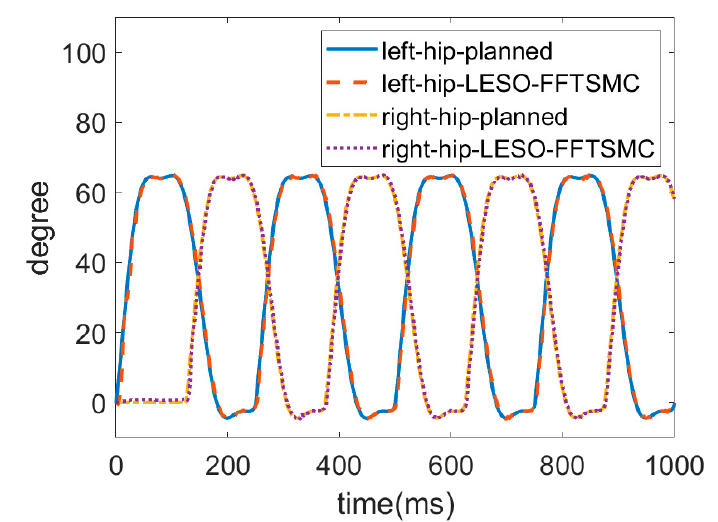
Figure 14. Trajectories of hip joints for ascending.